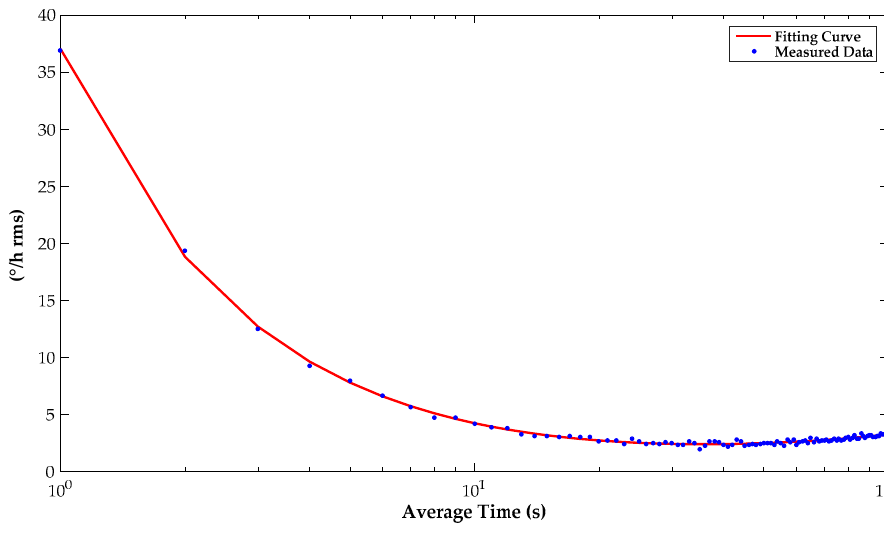
Figure 14. Standard Allan variance at 25 °C.